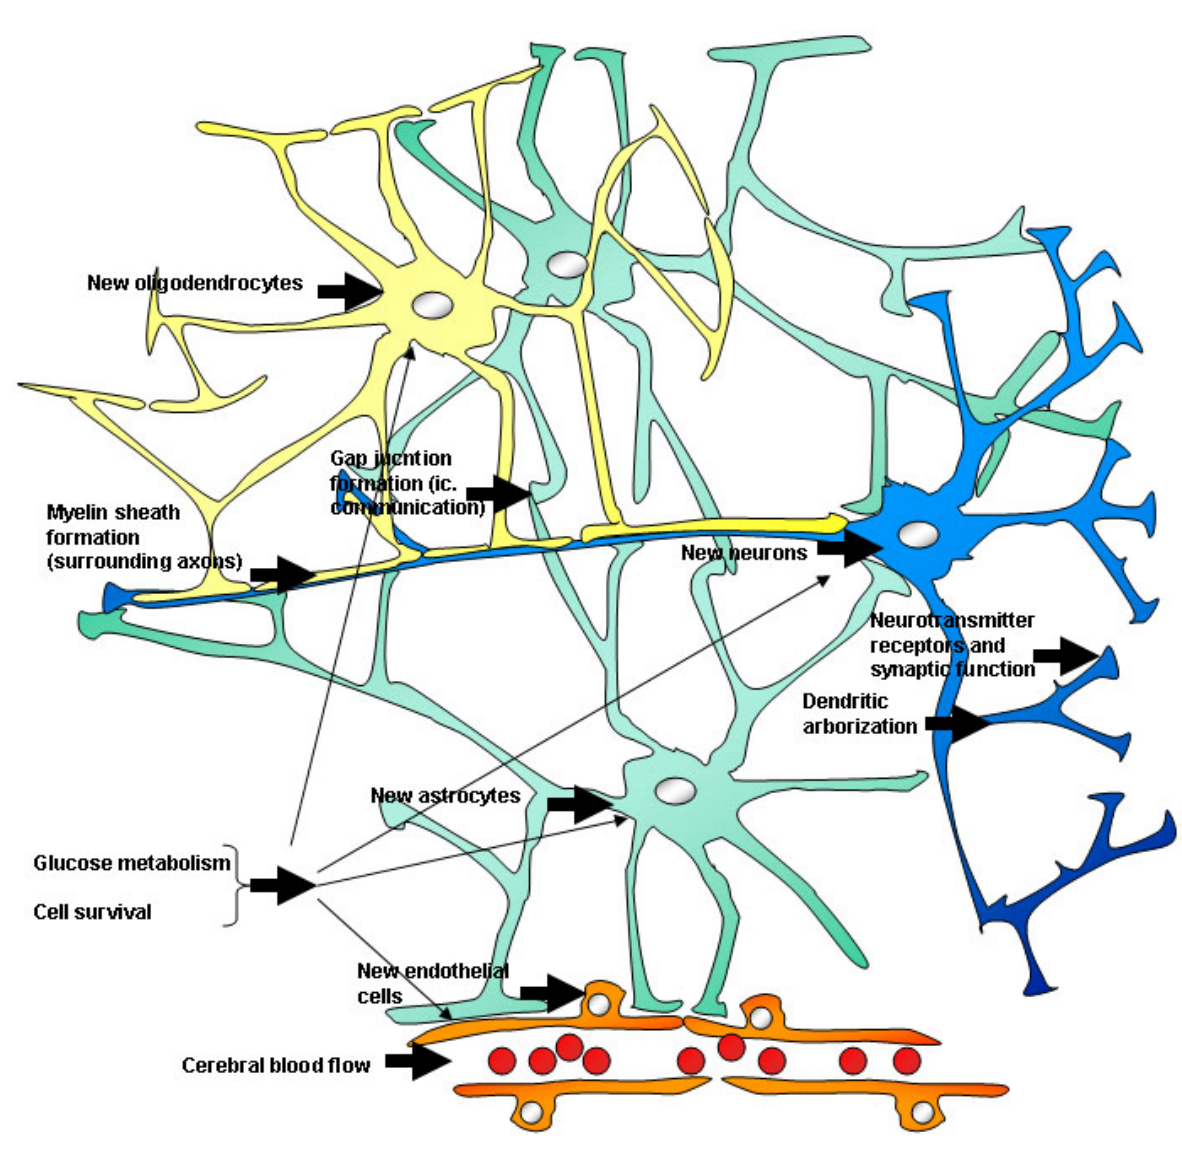
FIGURE 2. Schematic overview of the cellular interactions through which GH and IGF-I act. Yellow = oligodendrocyte; blue = neuron; green = astrocyte; red = blood vessel and erythrocytes. Arrows indicate the cellular targets that are affected by GH and IGF-I. Details are comprehensively described in the main